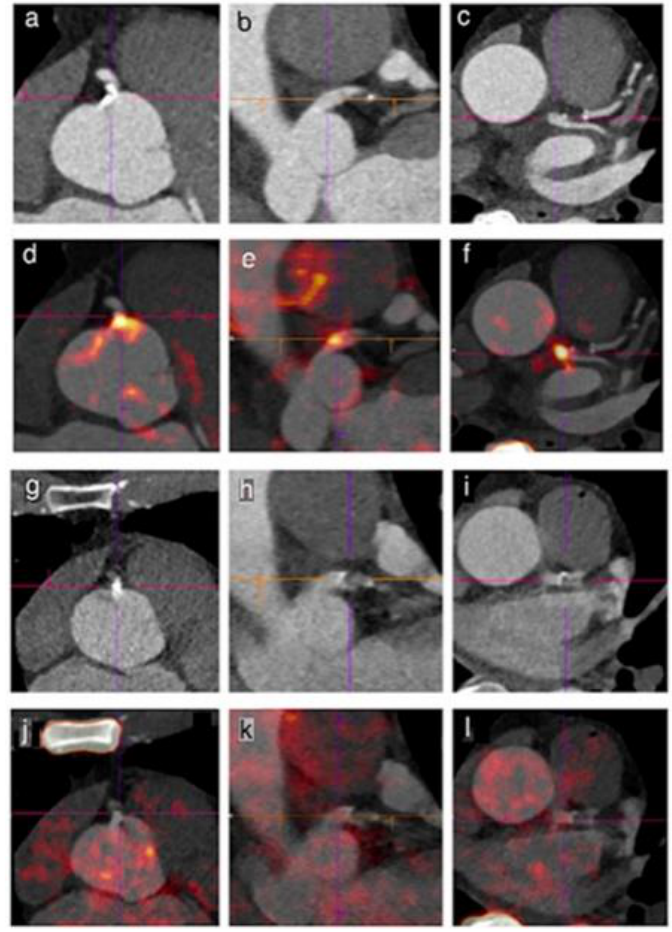
Figure 3. Reduced 18F-Sodium Fluoride Activity in Coronary Plaques after Statin Therapy. CT: single mixed plaque extending to the ostium and first segment of right coronary artery (RCA), smaller one in left main coronary artery (LM) and minor calcifications in left anterior descending artery (LAD); Agatston scores: ostium 198; RCA 169; LM 22; LAD 7 (panels a – c ). NaF-PET/CT: focal NaF uptake in ostium of RCA (panel d ; SUVmax1.9) and in LM (panels e and f ; SUVmax 2.5). Six months later following a regimen of 10 mg rosuvastatine and 75 mg aspirin per day with advising of diet and regular physical activity, CT was unchanged with Agatston scores: ostium 195; RCA 163; LM 23, LAD 9, while there was a decrease in focal NaF uptake in the coronary plaques (panels g – l ; respective SUVmax 1.2 and 1.5), without new hotspots. Reprinted with permission from Dietz et al. [44]). 2021, Oxford University Press.